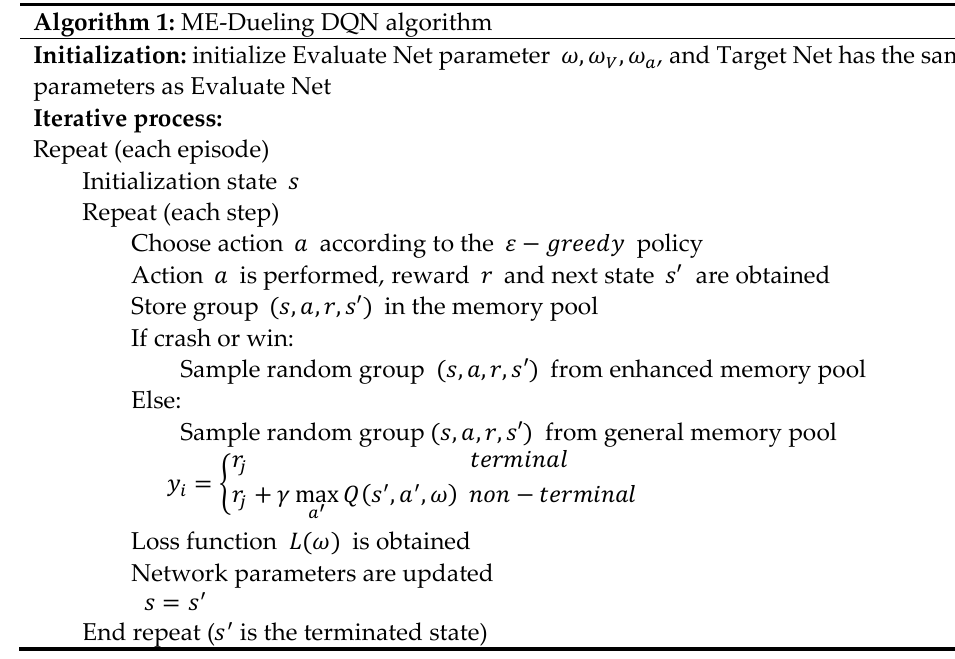
13 of 27 Figure 4. Memory-enhanced dueling deep q-network model. Figure 4. shows the path planning process of the ME-Dueling DQN algorithm in de- tail. The whole process can be divided into two parts: the interaction process with the environment and the learning process. We first introduce the process of the algorithm interacting with the environment. First, the state (cid:1871) containing the UH position infor- mation will be utilized as the input of the algorithm, and the corresponding action (cid:1853) in the state (cid:1871) will be output by the algorithm. Then, when UH performs action (cid:1853) , the envi- ronment will transition from state (cid:1871) to state (cid:1871)′ and the reward (cid:1870) corresponding to action (cid:1853) will be obtained. At this point, the complete quaternary information group ((cid:1871), (cid:1853), (cid:1870), (cid:1871) (cid:4593) ) is obtained. Finally, according to the experience replay mechanism, the quaternary infor- mation group ((cid:1871), (cid:1853), (cid:1870), (cid:1871) (cid:4593) ) will be stored in the experience pool (all quaternary information groups will be stored in the General Memory Pool, but the Enhanced Memory Pool only stores commands impressive memory). Next, we introduce the learning process of the algorithm. After the memory pool has stored a certain scale of data, the algorithm can start random sampling learning on the memory pool. It is worth noting that under normal cir- cumstances we sample from General Memory Pool, and only sample from Enhanced Memory Pool when the UH crashes or completes the mission. These collected samples are fed into the neural network for learning. First, the current state (cid:1871) will be used as the input of Evaluate Net to get the actual value (cid:1843) , and the next state (cid:1871)′ will be used as the input of Target Net to get the estimated value (cid:1843)′ . Then (cid:1843) , (cid:1843)′ and reward (cid:1870) are used as input to the loss function to get the mean squared error. Finally, the algorithm uses stochastic gradient descent to update the Evaluate Net, thus completing the optimization of the ac- tion selection strategy. In this process, the parameters of Evaluate Net will be completely copied to Target Net after a certain round of iteration to ensure the update of Target Net. After the above process, the ME-Dueling DQN algorithm completes the entire path